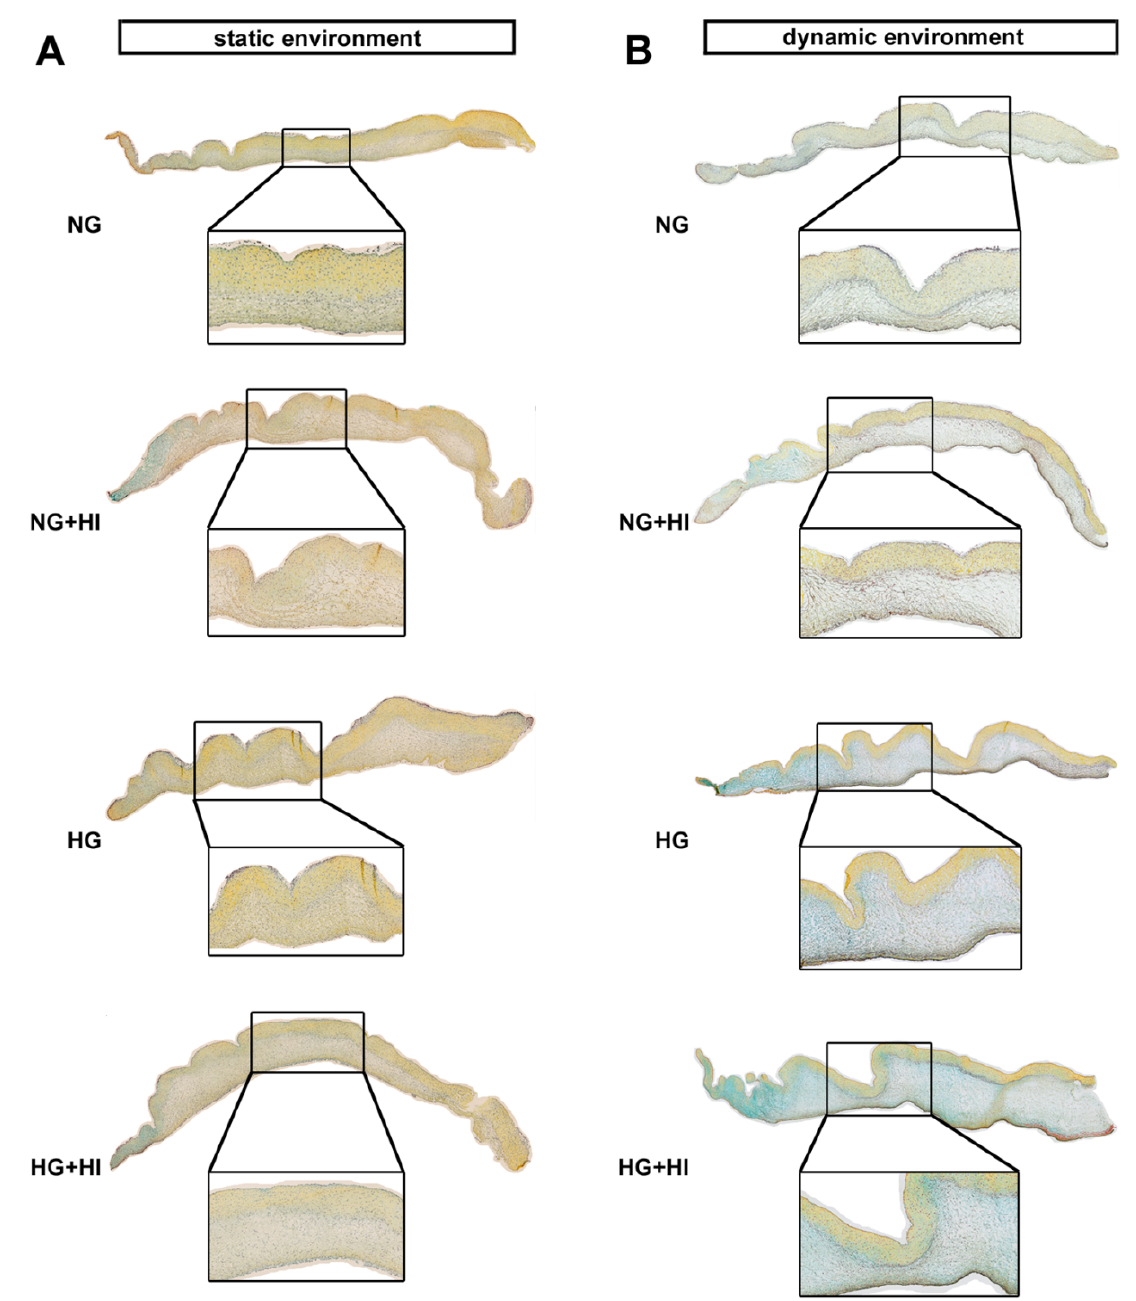
Figure 5. ECM composition of AV leaflets. ( A , B ) Representative images of Movat’s pentachrome staining of the cultivated leaflets with the aortic side up and the free edge to the left. Movat’s pentachrome stainings displayed a heterogeneous distribution of collagen (yellow) and proteoglycans (blue-green) in AV cross sections under the static ( A ) and dynamic environment ( B ). AV leaflets under dynamic conditions displayed stronger staining for proteoglycans ( B ). n = 5–6; NG: normoglycemia; HI: hyperinsulinemia; HG: hyperglycemia.